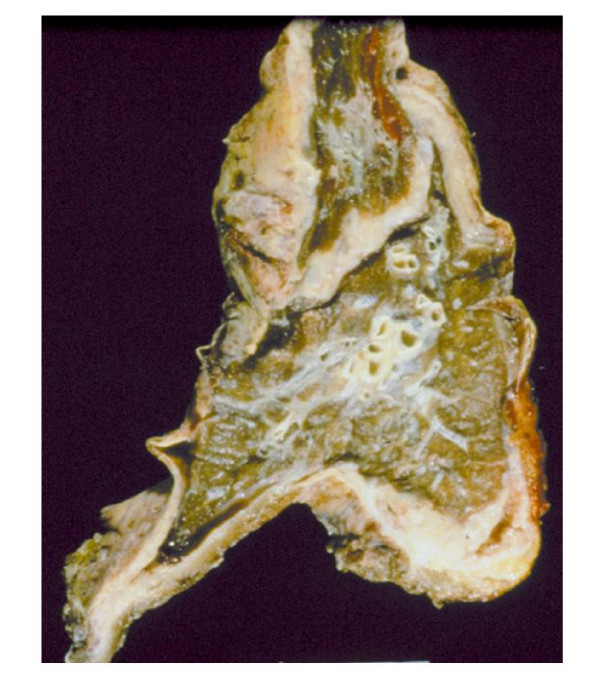
Gross specimen of malignant pleural mesothelioma. Presented here is an advanced case of malignant pleural mesothelioma encasing the lung and limiting lung compliance. Diffuse growth into the lung parenchyma is also present. (Personal photo of Neragi-Mianoab).